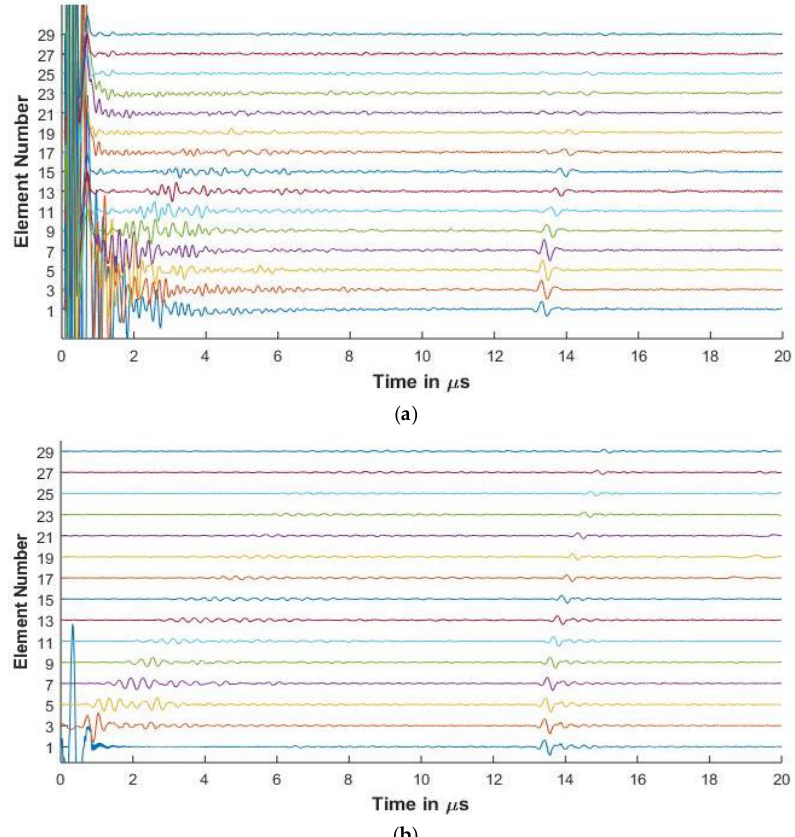
Figure 10. ( a ) Experimental FMC signals obtained for CFRP with 5 MHz 128 element array ( b ) Simulated FMC signals for CFRP with 5 MHz 128 element array.